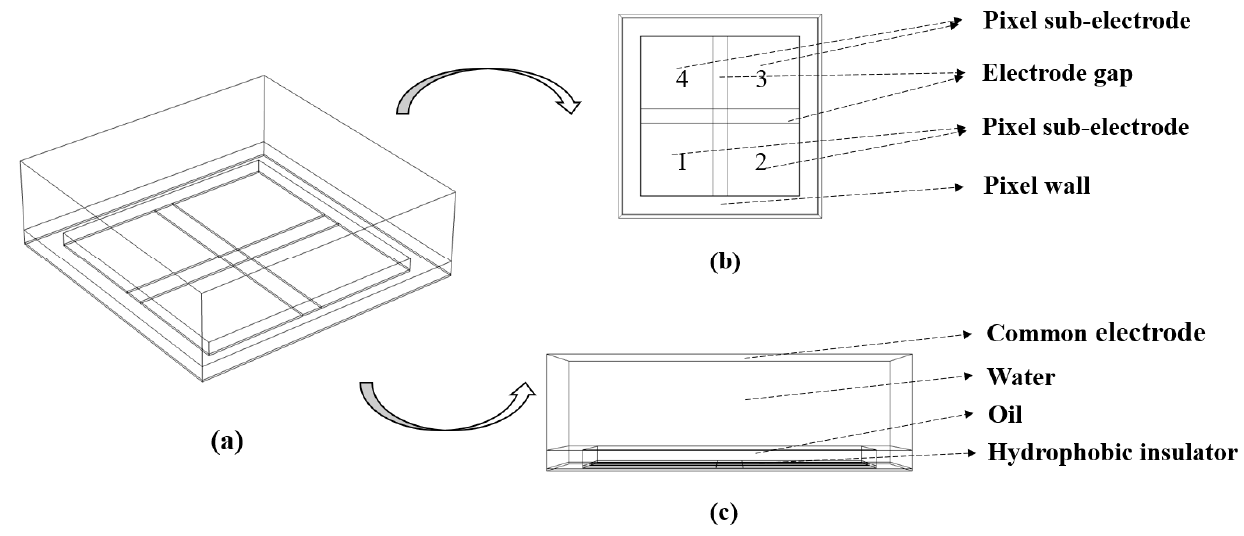
Figure 3. Multi-electrode pixel structure model diagram of an EWD pixel. ( a ) Three-dimensional simulation model of a multi-electrode structure in a pixel. The pixel was divided into a field shape with four sub-electrodes. ( b ) Top view of the multi-electrode pixel structure. ( c ) Side view of the multi-electrode pixel structure.